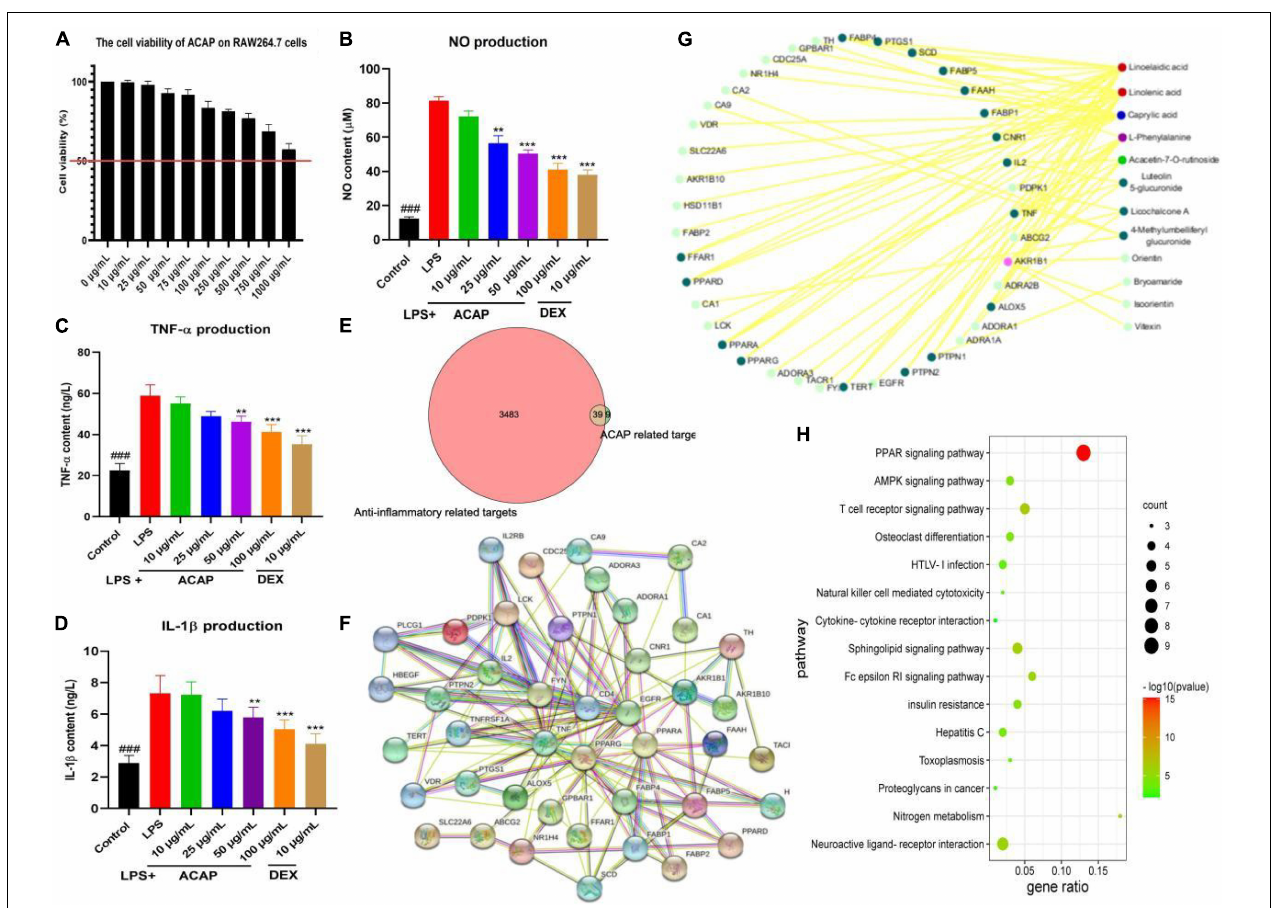
FIGURE 2 | The cell viability of aerial parts of A. coerulea (ACAP) against RAW264.7 cells (A) , and the nitric oxide (NO) content (B) , tumor necrosis factor (TNF)- α content (C) , interleukin (IL)-1 β content (D) in RAW264.7 cells induced by lipopolysaccharide (LPS); the common targets between ACAP related and anti-inflammatory targets (E) , the core hub of targets (F) , the target-compounds network (G) , and the KEGG pathway (H) in the network pharmacology assay ( ### represent the significant difference between control group and model group, p < 0.001; ** p < 0.01 represent the significant difference between model group and drug treated group; *** p <